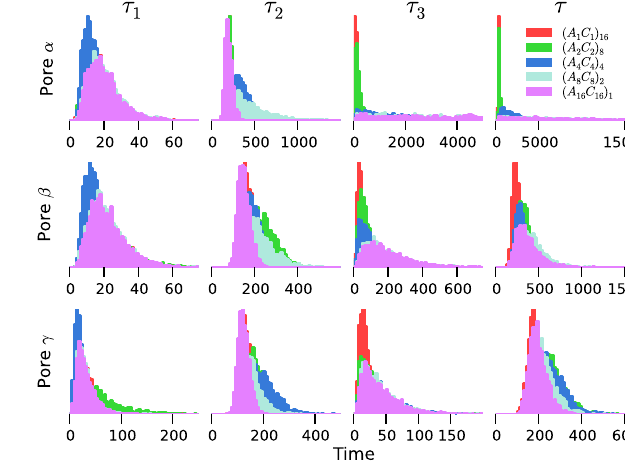
FIG. 9. Comparison of the filling, transfer, escape, and trans- location time distributions for the three pores at F ¼ 1 : 0 and W ¼ 2 : 5 using heteropolymers with different